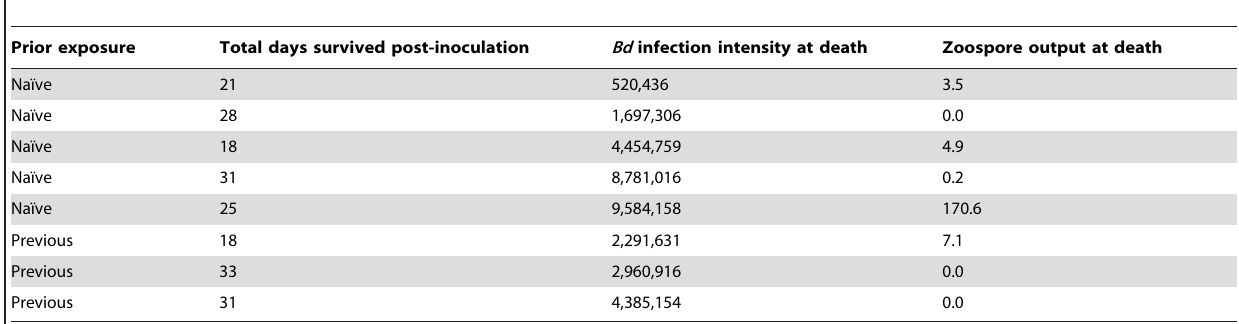
Table 1. Summary of Atelopus zeteki infection intensity (number of zoospores on skin swabs) and zoospore output (number of zoospores released per minute) at